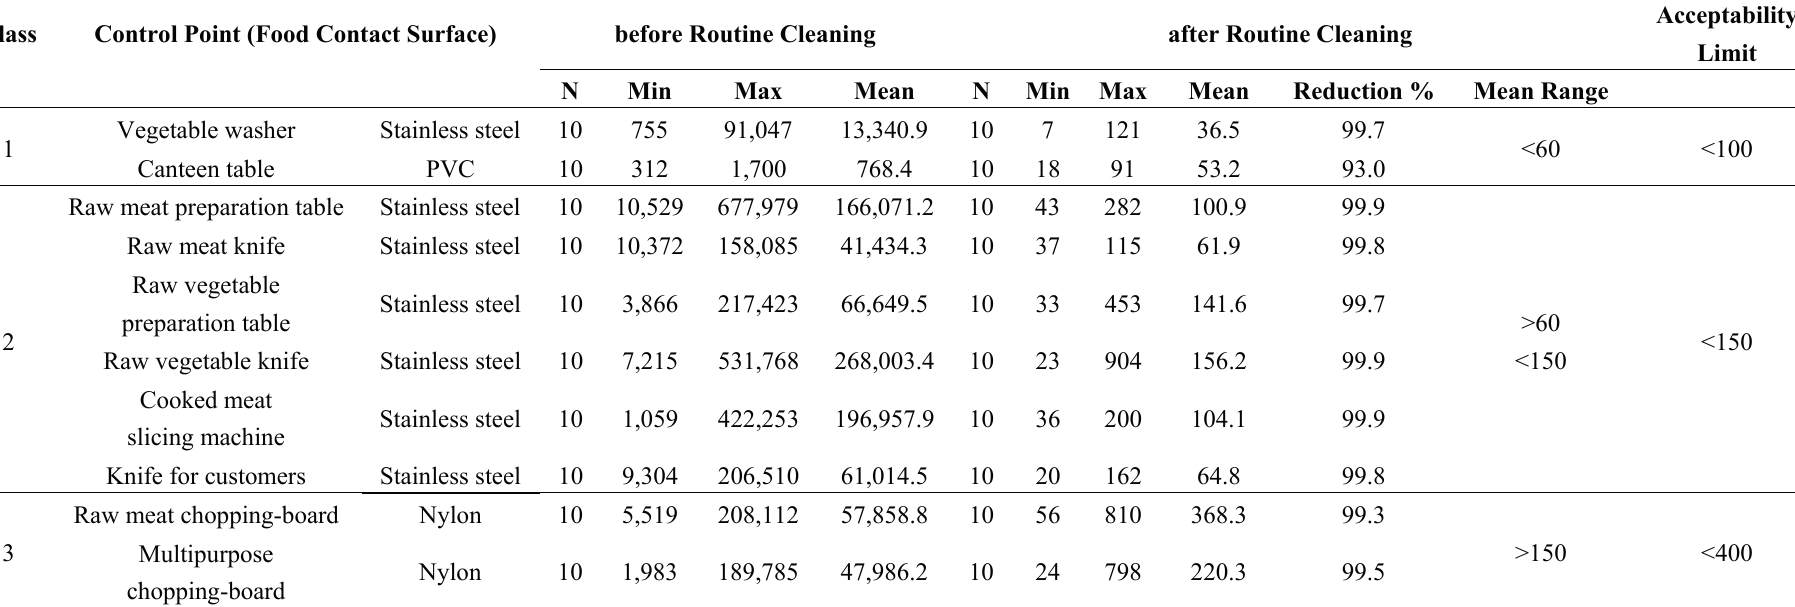
Table 1. Relative light units (RLU)/100 cm 2 measured on each surface before and immediately after cleaning and sanitation operations for preliminary definition of ATP bioluminescence acceptability